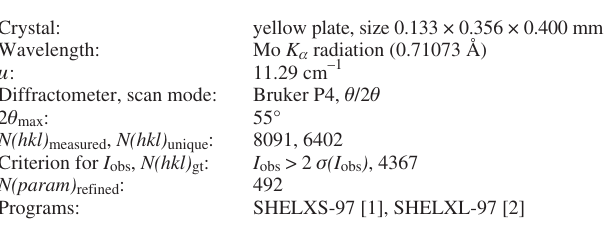
Table 1. Data collection and handling.